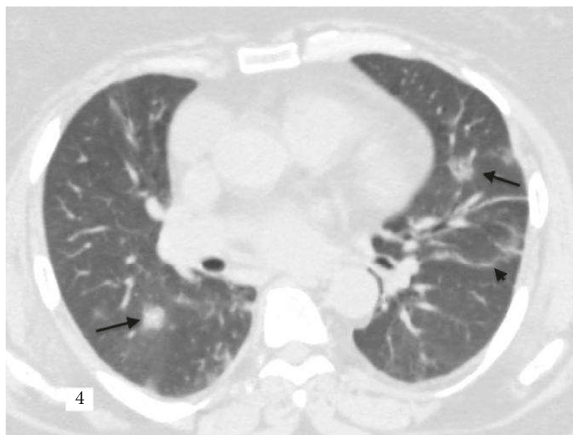
Figure 4: A 60-year-old female patient with influenza A (H1N1) pneumonia, known diabetes, and chronic kidney disease. According to the RSNA guidelines in the typical group, CORADS score is given as 5. Bilateral rounded consolidation areas (black arrows) and parenchymal band (black arrowhead) are observed.